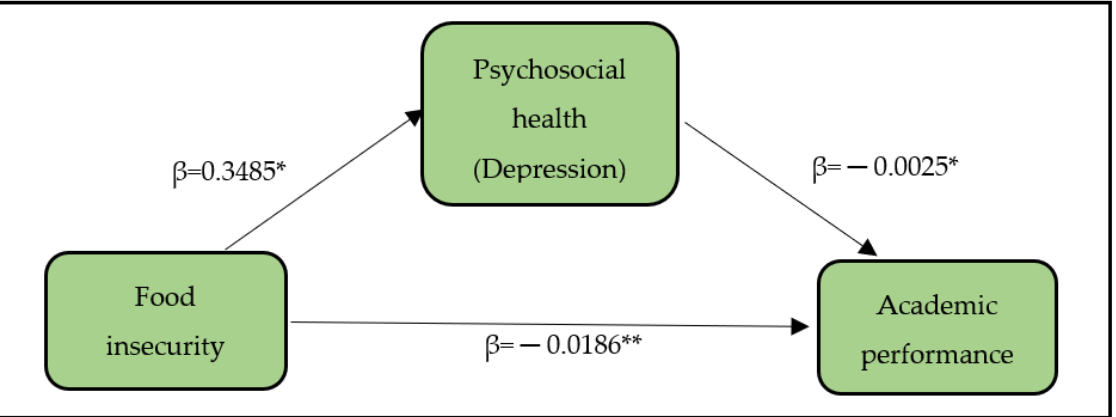
Figure 2. Framework for simple mediation (depression as mediator). * p -value < 0.05, ** p -value <